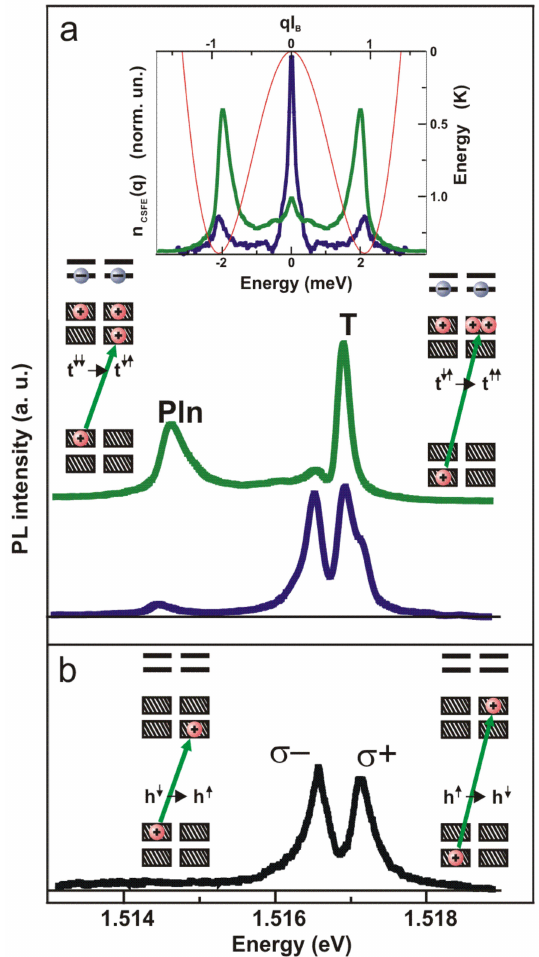
Figure 4. Photoluminescence spectra for sample 2. ( a ) Stationary excitation in case when the probing spot is separated from the pumping spot by ~200 µ m: (lower blue curve)—P probe = 3 µ W, P pump = 0; (upper green curve)—P probe = 3 µ W, P pump = 150 µ W. The upper inset shows the density distribution of plasmarons with respect to energy (lower scale) and momentum (upper scale) for two stationary excitation modes corresponding to the lower PL spectrum (blue curve) and the upper PL spectrum (green curve). The red curve represents the calculated dispersion of magnetoexcitons according to [17]. ( b ) Pulsed photoexcitation at τ p = 10 µ s, and P p = 100 µ W. The diagrams show possible optical transitions for two polarizations of